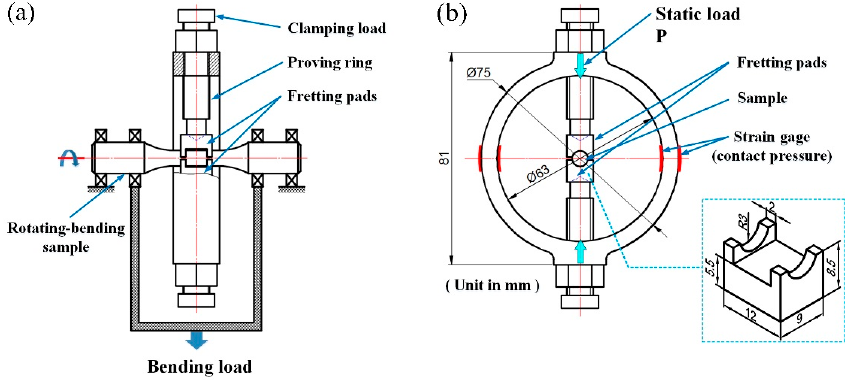
Figure 2. Schematic illustrations of the FF test apparatus ( a ) Principle of the rotary bending FF test; ( b ) shape and dimensions of the proving ring.